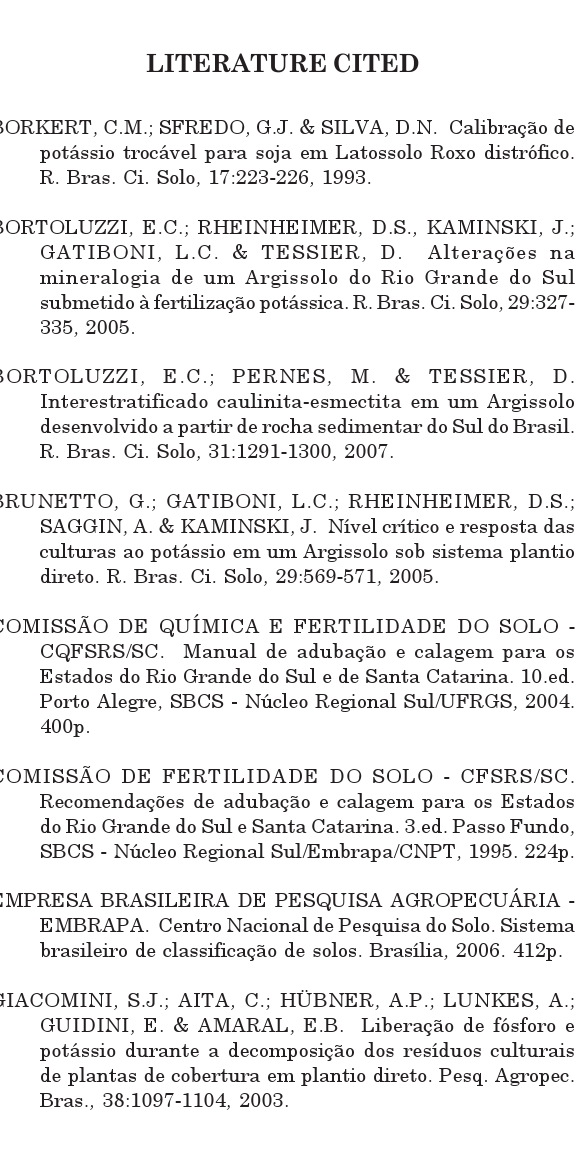
Figure 2. Vertical distribution of potassium extracted by Mehlich-1 in native field soil and submitted to the addition of K O doses, after 2 fifteen years of cropping in a Hapludalf soil (Argissolo Vermelho distrófico